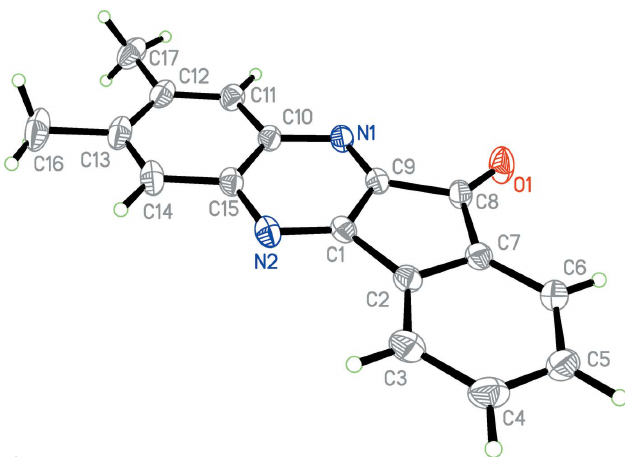
Figure 1 The molecular structure of the title molecule with the atom-labelling scheme. Displacement ellipsoids are drawn at the 30% probability